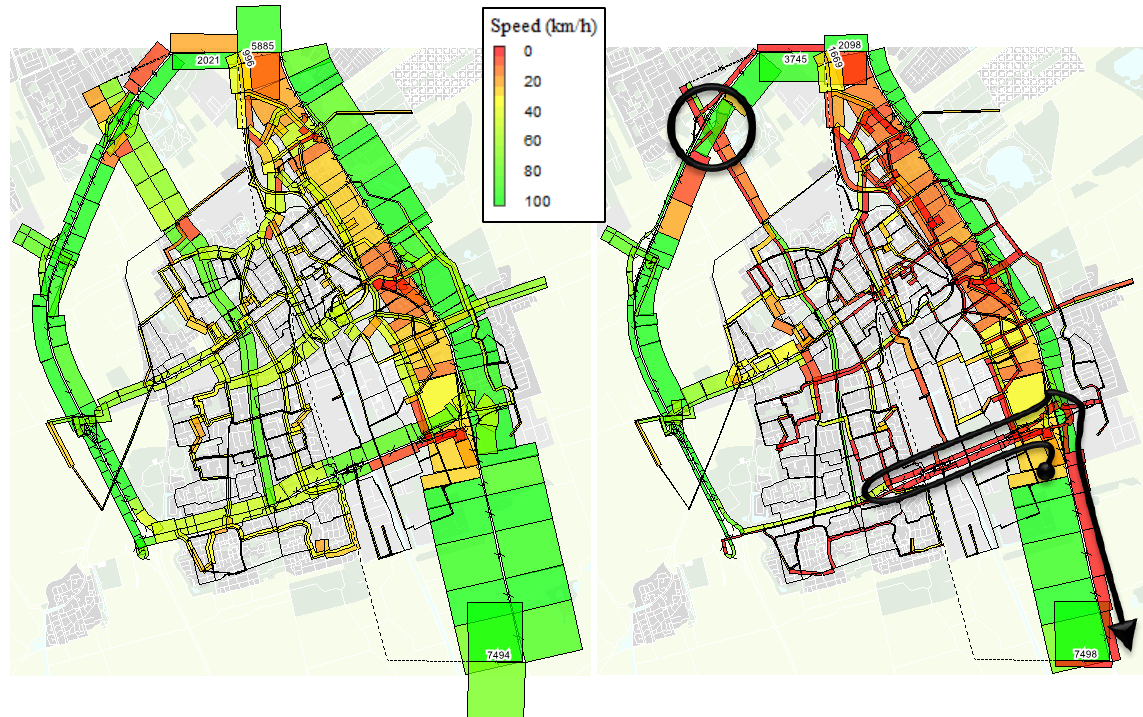
Figure 7. Average vehicle traffic flows (h -1 ) between 17:30 and 18:00 for the Delft case study (a) on a normal day (b) in the evacuation scenario Bar widths are proportional to flow, colors indicate traffic speed